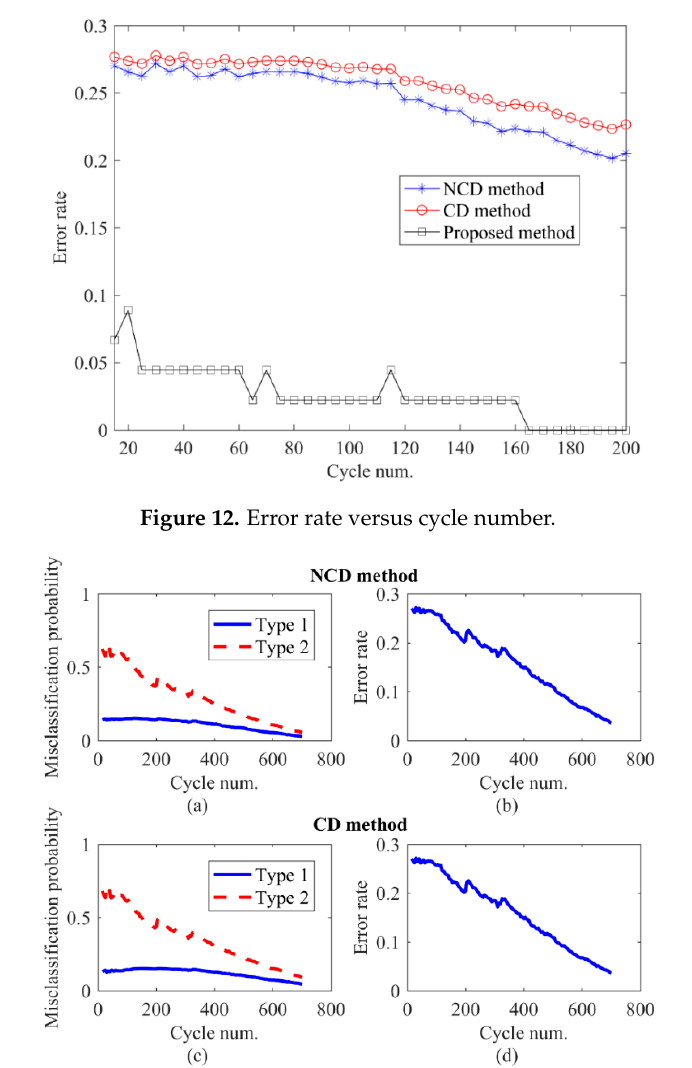
Figure 13. NCD and CD misclassification probability and error rate.